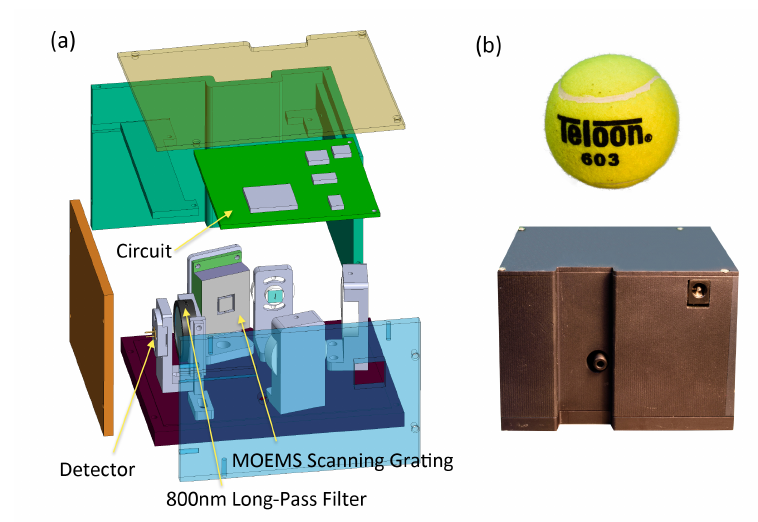
Figure 6. ( a ) Expanded assembly drawing of the spectrometer; ( b ) a single-detector NIR microspectrometer encased in an aluminum housing, which is comparable in size to a tennis ball.